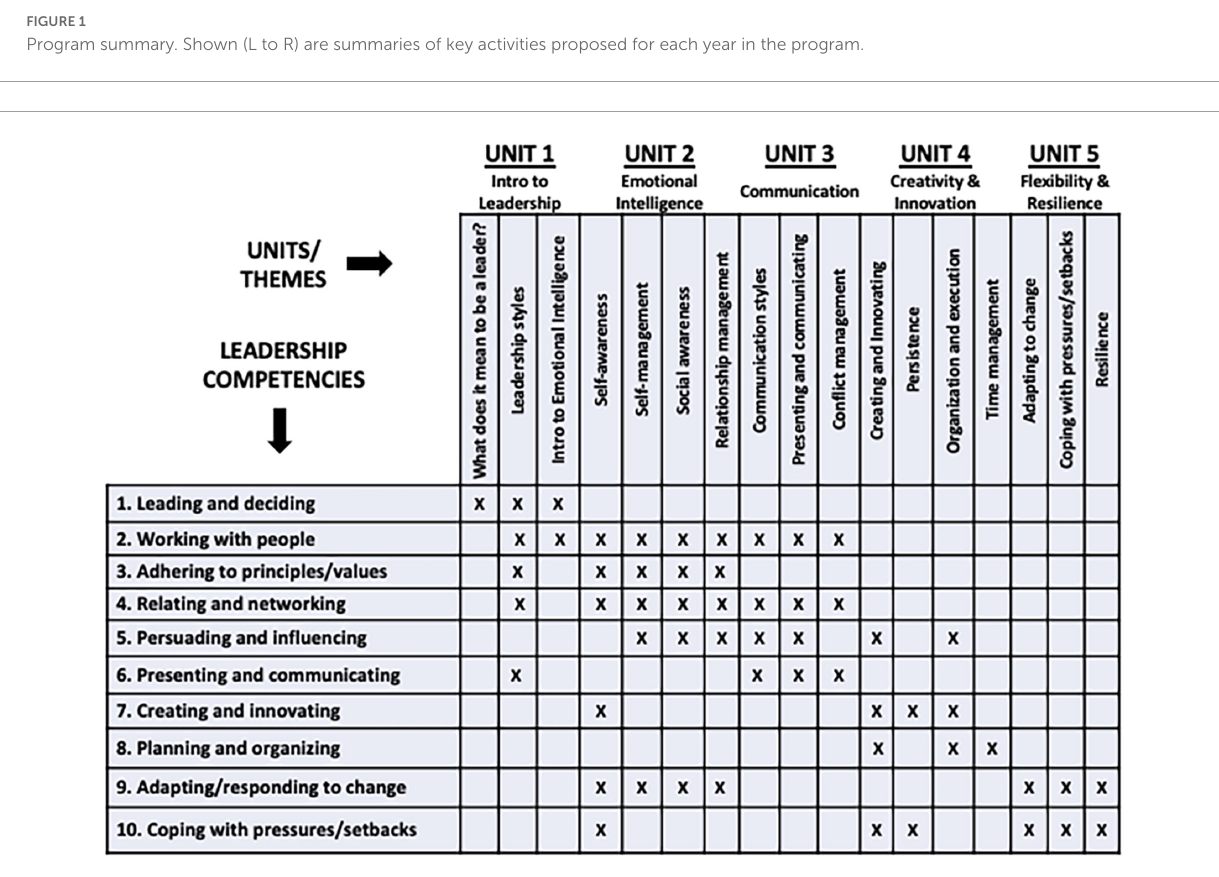
FIGURE2 Competency map. Shown (across) are the five year one units and associated sub-themes. Rows indicate specific leadership competencies derived from the OPQ. An "X" indicates, at minimum, the competency coverage addressed by a given unit sub-theme. Note that most competencies were covered by more units than indicated